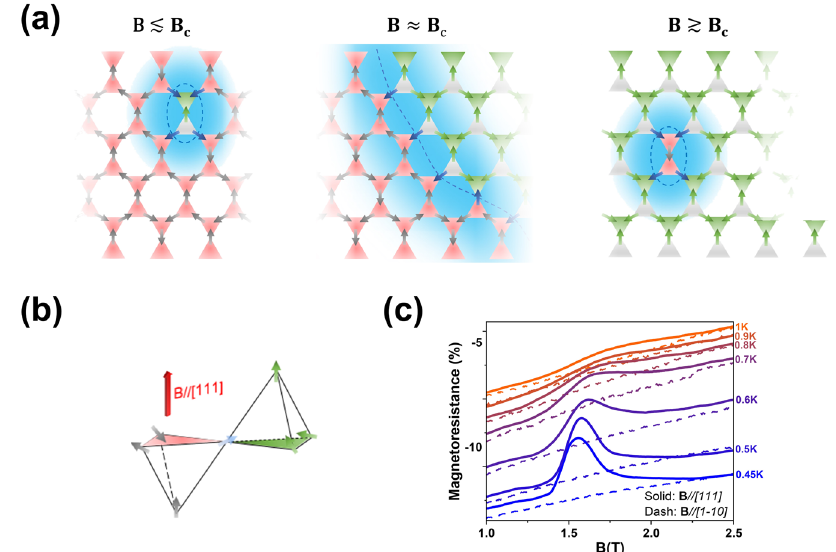
Fig.3|Phenomenologicalmechanism.a Schematicsshowingtheboundaryinthe Kagome layer between the Kagome spin ice and the saturated ice state. The tet- rahedra with the 2-in-2-out con fi guration and the 3-in-1-out (1-in-3-out) con fi gura- tion are in red and green, respectively. The blue arrows denote the sites that connect the two regions with the area highlighted in light blue indicating the